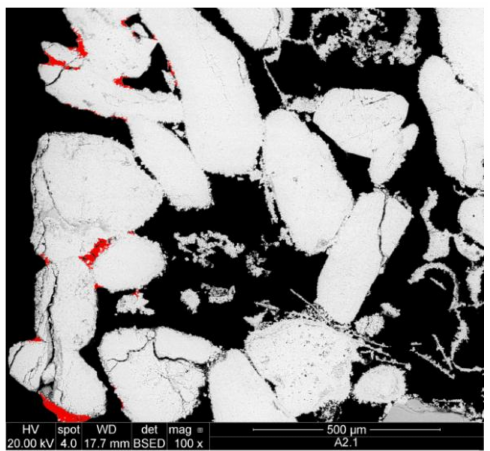
Figure 10. SEM-BSE of Au limestone with accumulation of consolidant (marked red) on the edges of the stone specimen.